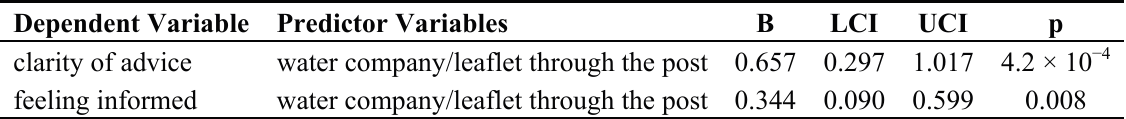
Table 5. Final parameter estimates of ANOVAs of predictors of clarity of advice and feeling informed.